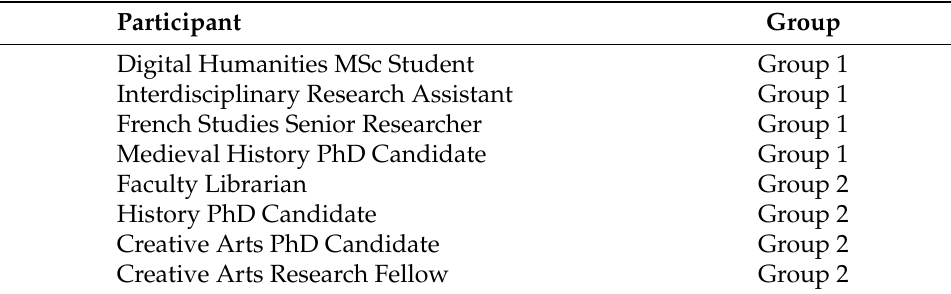
Table 1. Relation of participants and their assigned